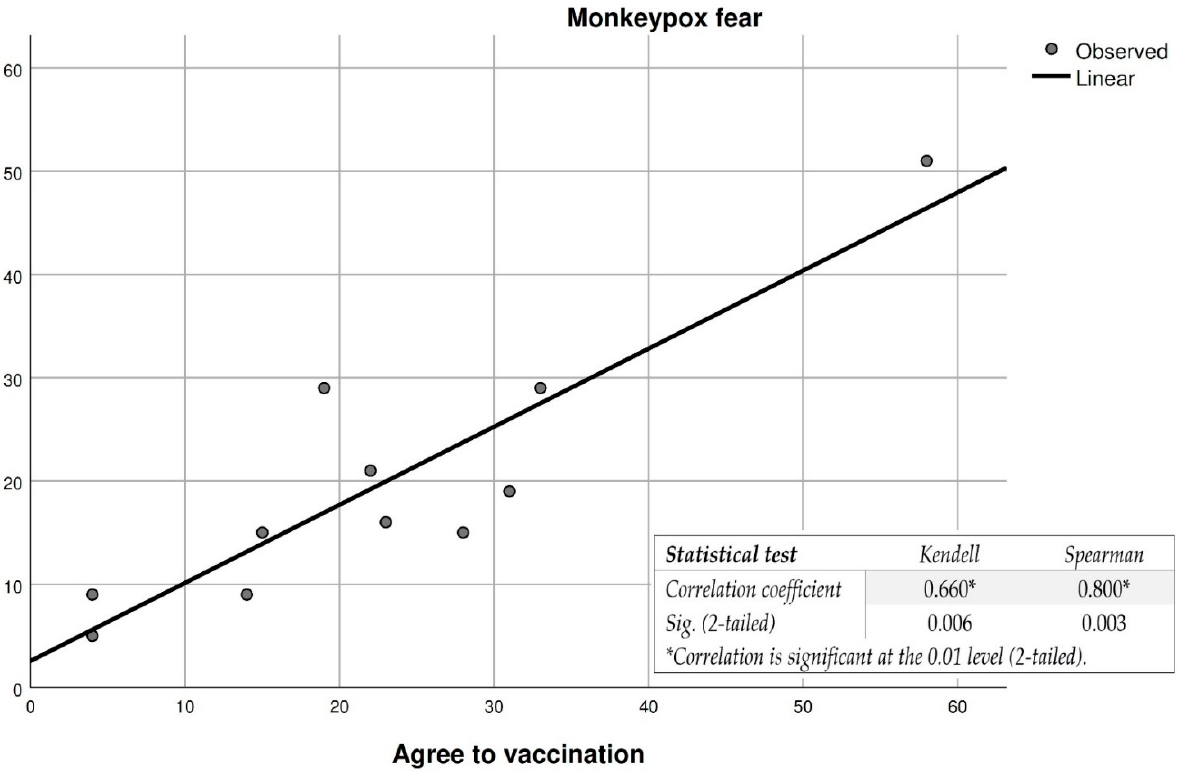
Figure 1. Correlation between fear of the monkeypox disease and the participants’ decision to vaccinate against the disease. * For a correlation to be very strong, the correlation coefficient must be as close as possible to 1, and sig. as close as possible to 0.